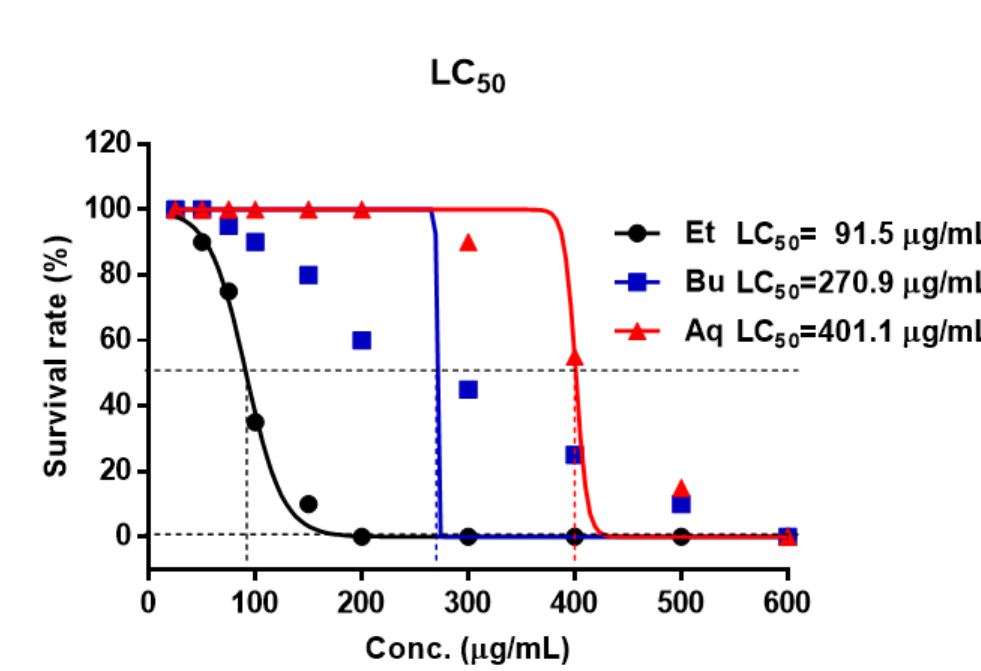
Figure 2. LC 50 of zebrafish embryos exposed to EtOAc, n -BuOH, and aqueous Frs for 96 h. The LC 50 of Et was 91.5 µ g/mL. The LC 50 of Bu and Aq were 270.9 µ g/mL and 401.1 µ g/mL, respectively. NOR: normal group, Et: EtOAc fraction, Bu: n -BuOH fraction, Aq: aqueous